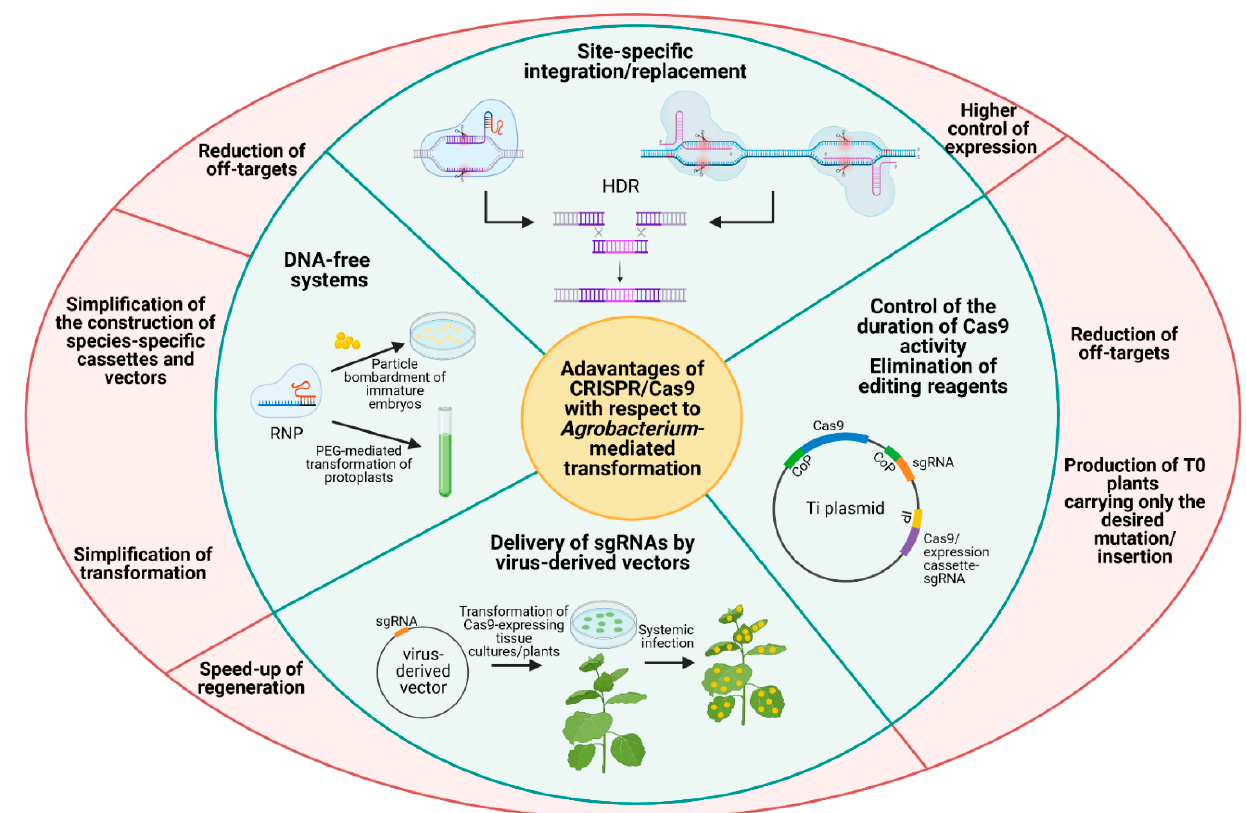
Figure 1. Advantages of the CRISPR/Cas9 method with respect to Agrobacterium -mediated transformation. The pecu- liarities of CRISPR/Cas9 (indicated in the green part) with the corresponding ameliorations (indicated in the red part), in comparison to the conventional Agrobacterium -based transformation, are represented. HDR = homologous-derived repair, CoP = constitutive promoter, sgRNA = single guide RNA, RNP = ribonucleoprotein. Created with Biorender.com (https://biorender.com/; accessed on 20 April 2021).